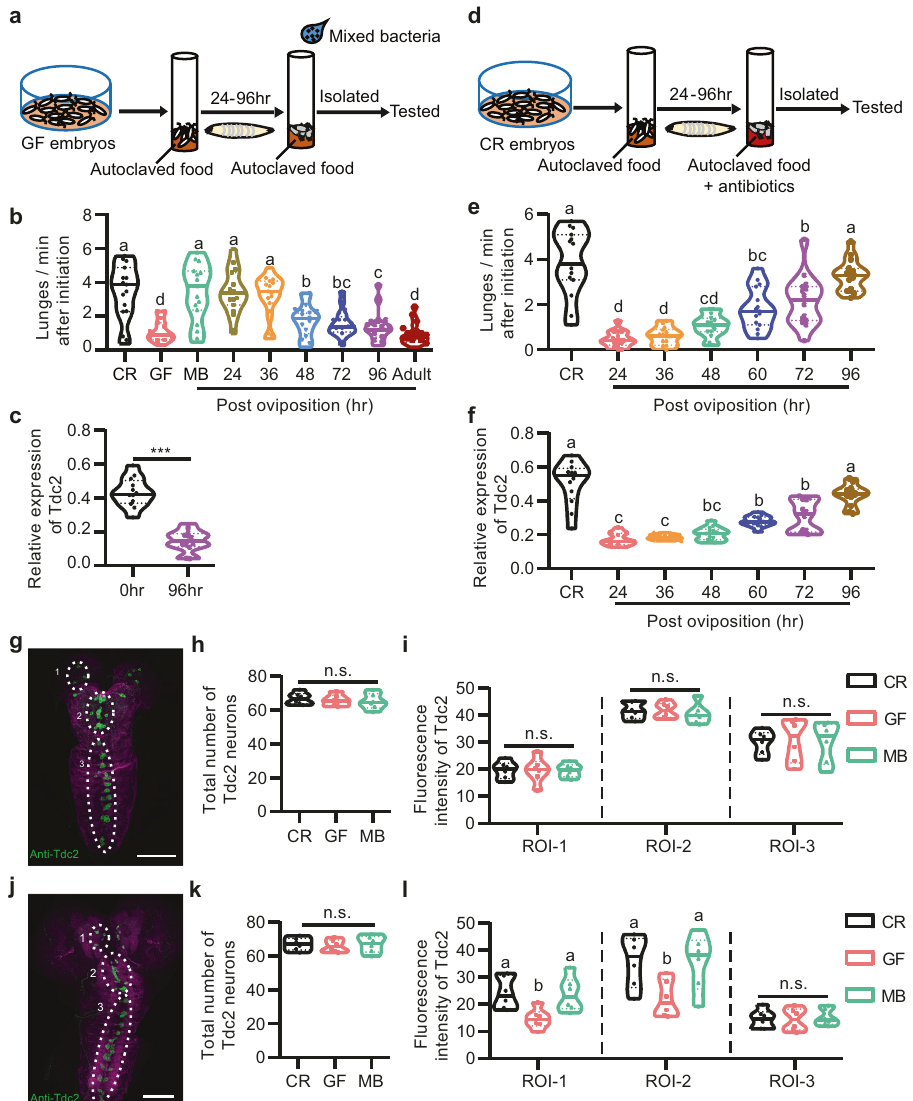
Fig. 5 Microbiome promotes aggression during a critical developmental period. a Experimental setup to assess the impact of delayed association of microbiome on aggression gain. b Lunging frequency of GF males recolonized at different developmental time points. Recolonization of mixed bacteria in early stages of development, but not later or adult stage, fully or partially restored aggression in GF males. n = 15 for each. c Relative expression of Tdc2 mRNA in GF males recolonized with mixed bacteria at different developmental stages. n = 12 based on three replicates for each. *** p < 0.001, Two-tailed Mann – Whitney U -test. d Experimental setup to assess the impact of bacterial ablation during development on aggression of adult males. e Lunging frequency of adult males after above manipulation. Ef fi cient bacterial ablation by antibiotics was assessed by plating adult homogenates at the time of collection on LB agar plates. n = 15 for each. f Relative expression of Tdc2 mRNA in adult males after above manipulation. n = 12 based on three replicates for each. g Representative image of the anti-Tdc2 signals in CNS of larva 36 – 48 h AEL. Scale bars, 50 μ m. h Total numbers of Tdc2 neurons in CR, GF, and MB larva 36 – 48 h AEL were not signi fi cantly different. n = 6 for each. i Fluorescence intensities of anti-Tdc2 signals in ROI-1, ROI-2, and ROI-3 were calculated in CR, GF, and MB larva 36 – 48 h AEL. n = 6 for each. j Representative image of the anti-Tdc2 signals in CNS of larva 72 – 84 h AEL. Scale bars, 50 μ m. k Total numbers of Tdc2 neurons in CR, GF, and MB larva 72 – 84 h AEL were not signi fi cantly different. n = 6 for each. l Average fl uorescence intensities of anti-Tdc2 signals in ROI-1, ROI-2, and ROI-3 were calculated in CR, GF, and MB larva 72 – 84 h AEL. n = 6 for each. For all variables have different letters, they are signi fi cantly different ( p < 0.05). If two variables share a letter, they are not signi fi cantly different ( p > 0.05). Kruskal – Wallis test followed by Dunn ’ s multiple comparisons